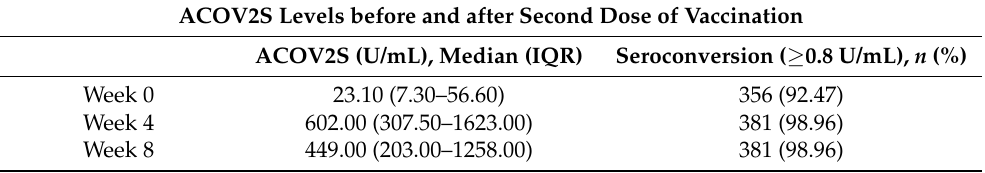
Table 2. Humoral Responses of HD Patients ( n = 385) after Second Dose of ChAdOx1 nCoV-19 Vaccine. ACOV2S Levels before and after Second Dose of Vaccination